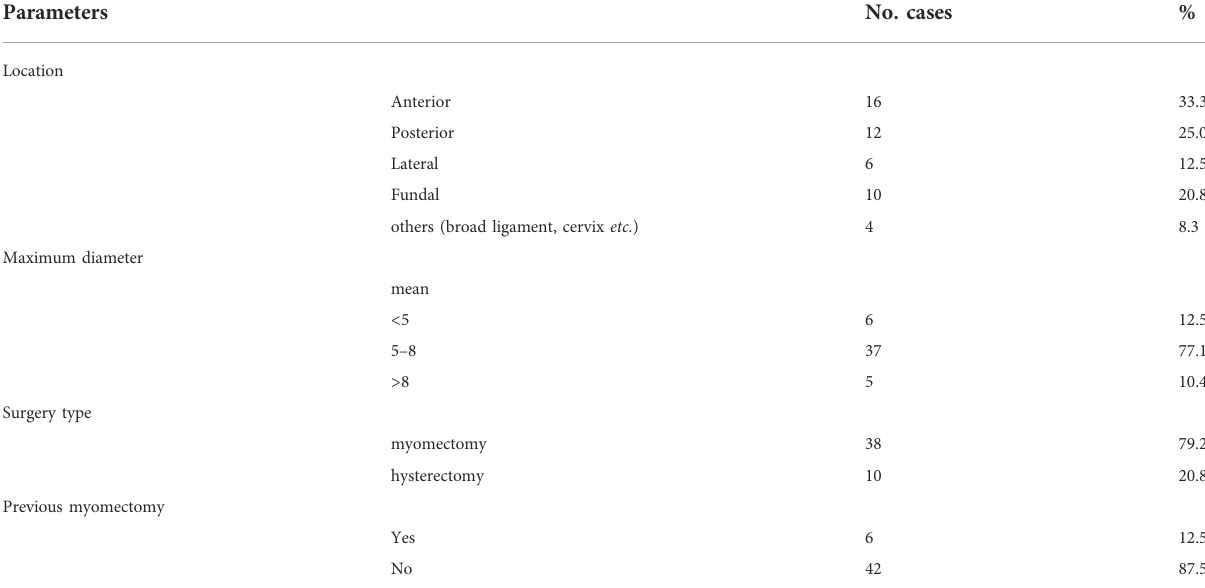
TABLE 4 Fibroid characteristics in participants with fi broids (n = 48).